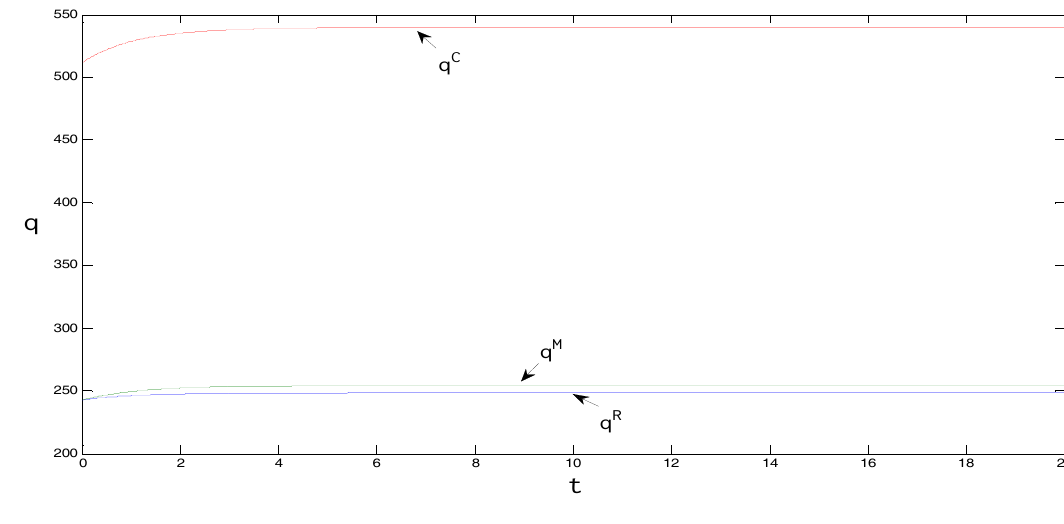
Figure 3. Comparison of market demand.